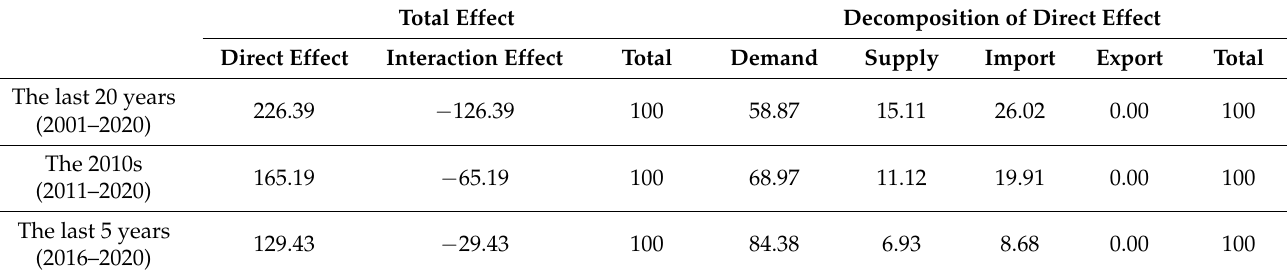
Table 6. Price fluctuation analysis results of dried red